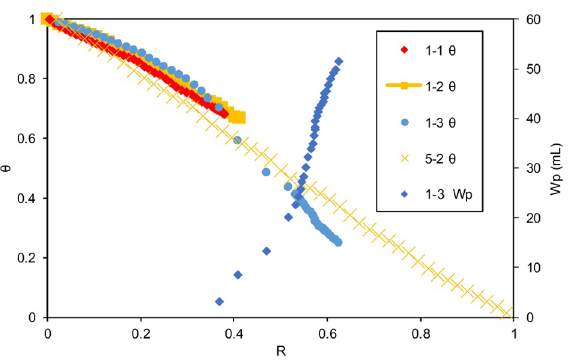
Figure 6. Relationship between relative apparent pressure of the formation and R